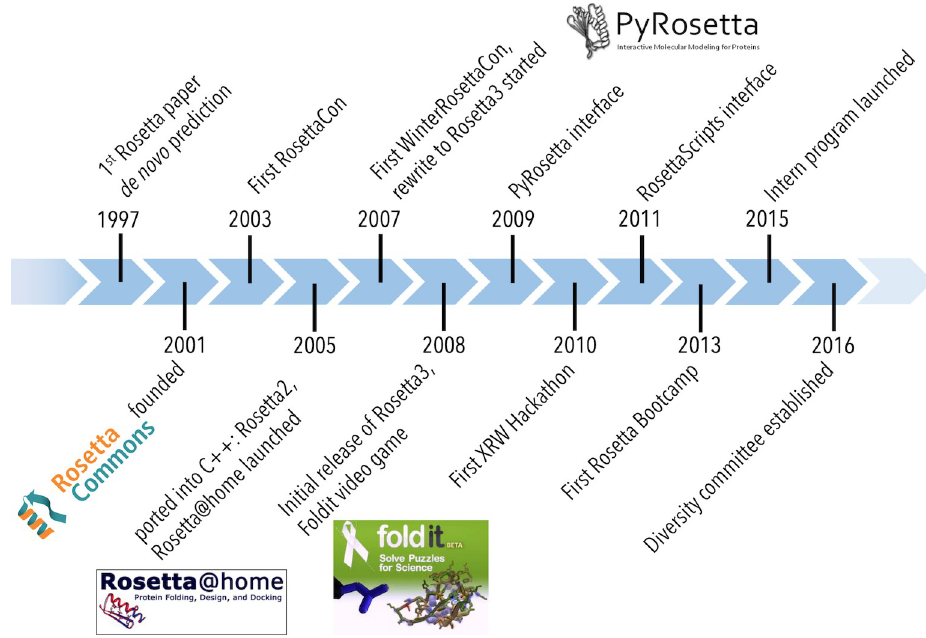
Fig 3. Rosetta history. Major milestones in the history of Rosetta